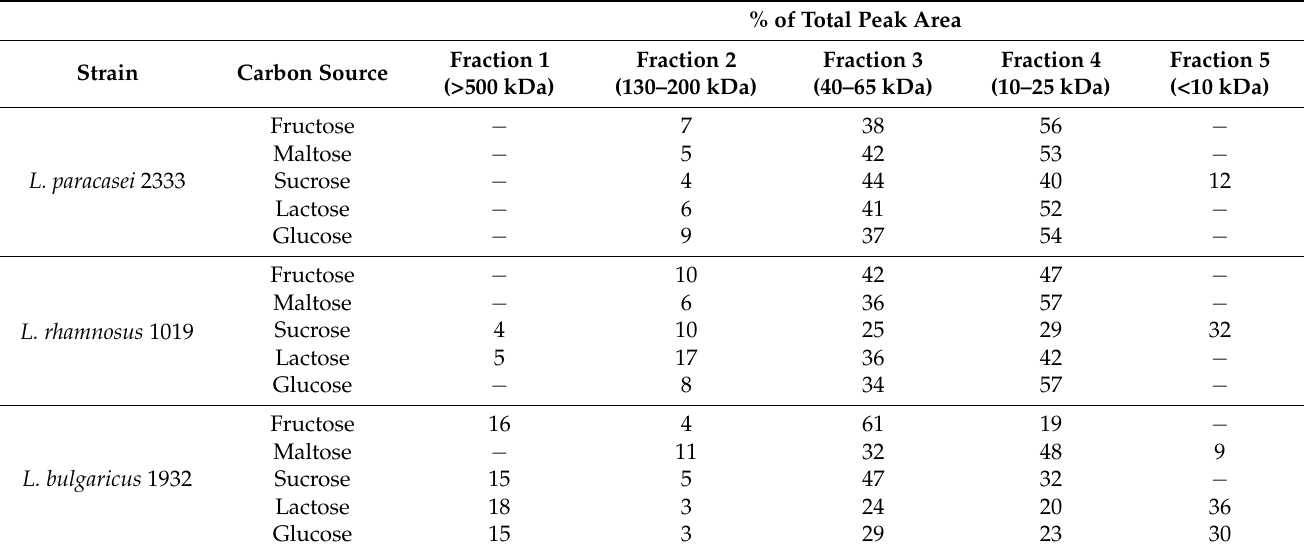
Table 2. Molecular weight profile (expressed as relative percentage of total chromatographic area) of EPS produced by three LAB strains, fed with five different carbon